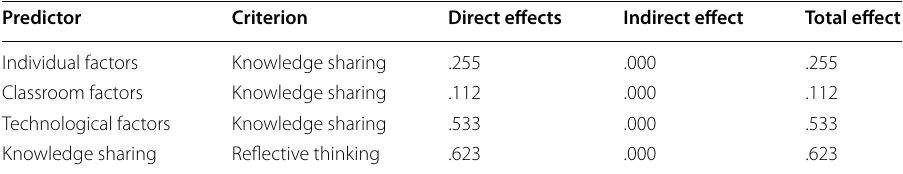
Table 9 Standardized loadings for direct, indirect, and total effects